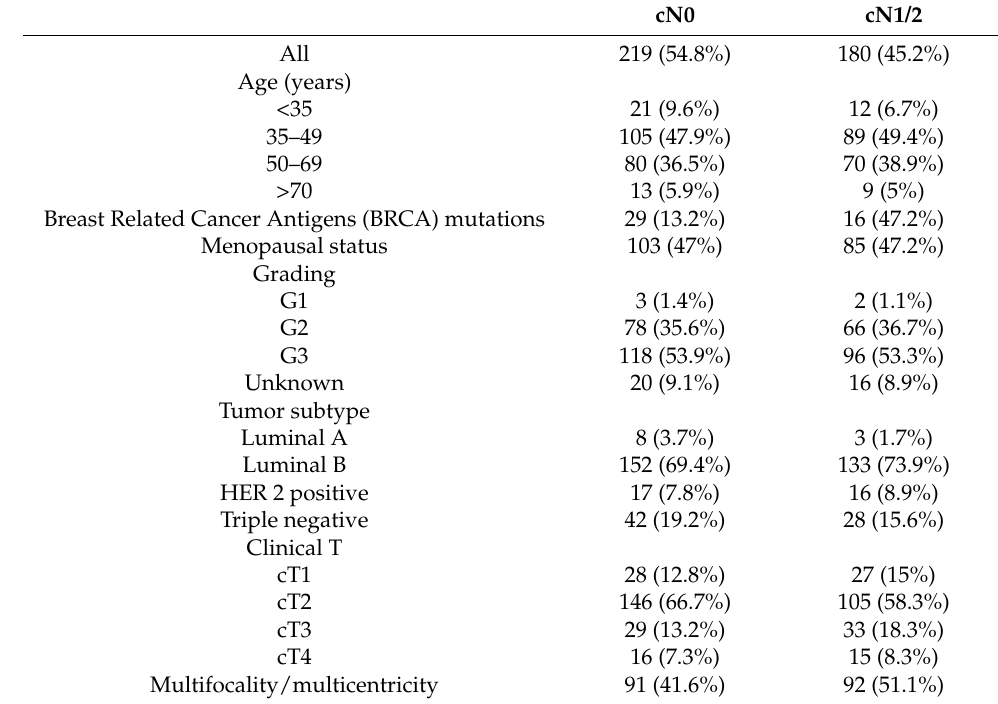
Table 1. Clinical characteristics of 399 patients according to cN status prior to neoadjuvant